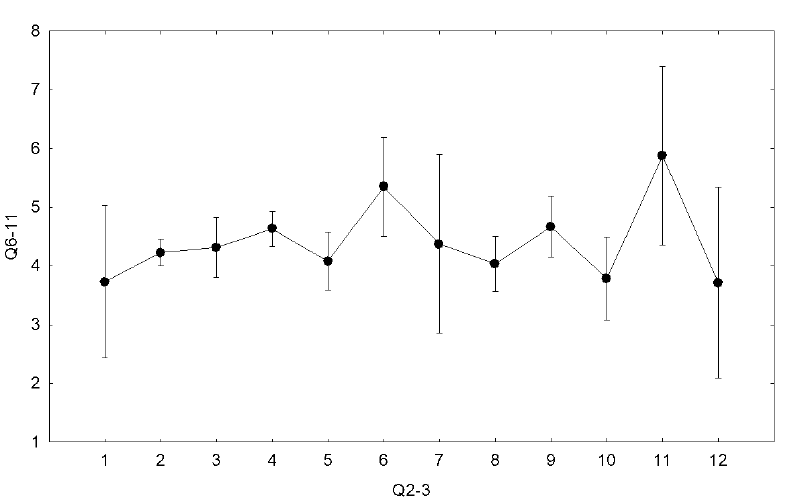
Figure 3. The values belonging to Q6-11 are split into 12 subgroups by Q2-3. Means are denoted by points and confidence intervals by bars.